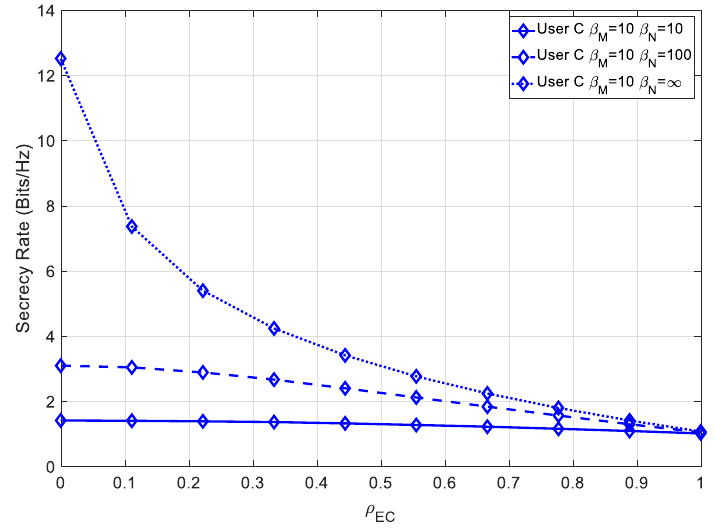
Figure 12. Secrecy rate of the 8 × 8 receiver C with different channel estimation errors and a permanent channel mismatch error.